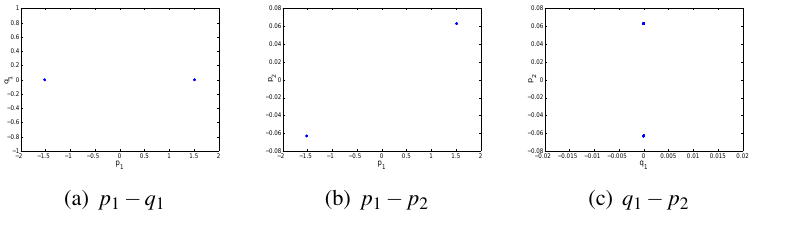
Fig. 6 Section of global random basic attractors for ϕ NGM 3 with case III